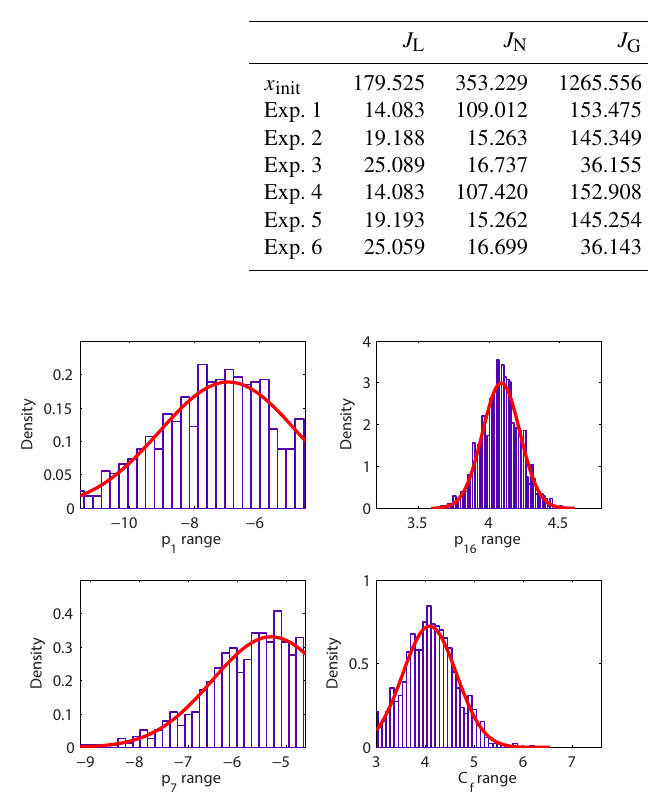
Figure 12. Posterior parameter distributions for parameters p 1 , p 7 , p 16 and C f for Exp. 6. For each plot the limits of the abscissa cor- respond to the parameter range. The red curve is the Gaussian pos- terior distribution and the blue bars represent the sample used to produce the grey trajectories in Figs. 10 and